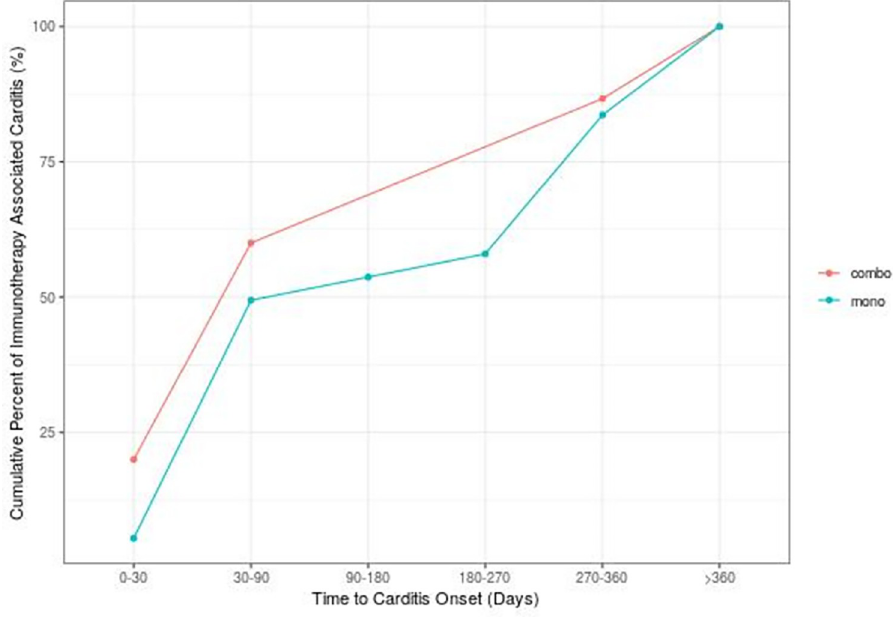
Fig 1. Cumulative incidence of time to carditis onset from initiation of immune checkpoint inhibitor monotherapy (turquoise) or combination therapy (pink).